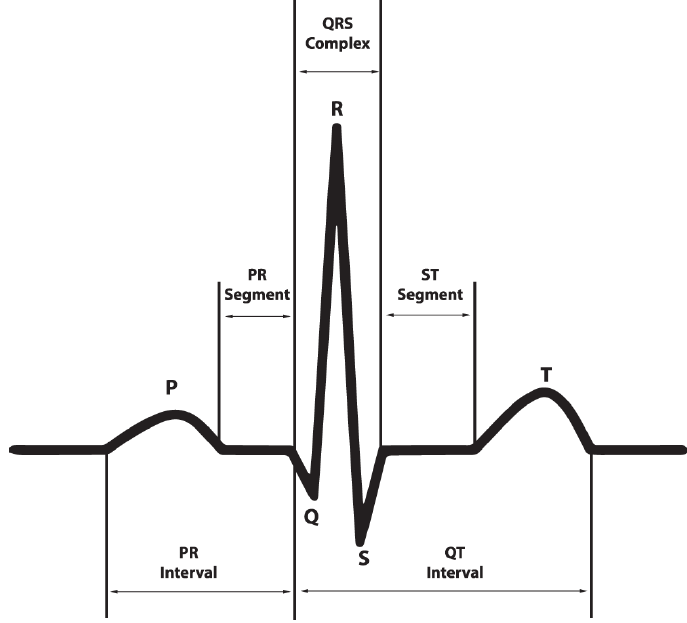
Figure 1. Electrocardiogram. Figure 1.